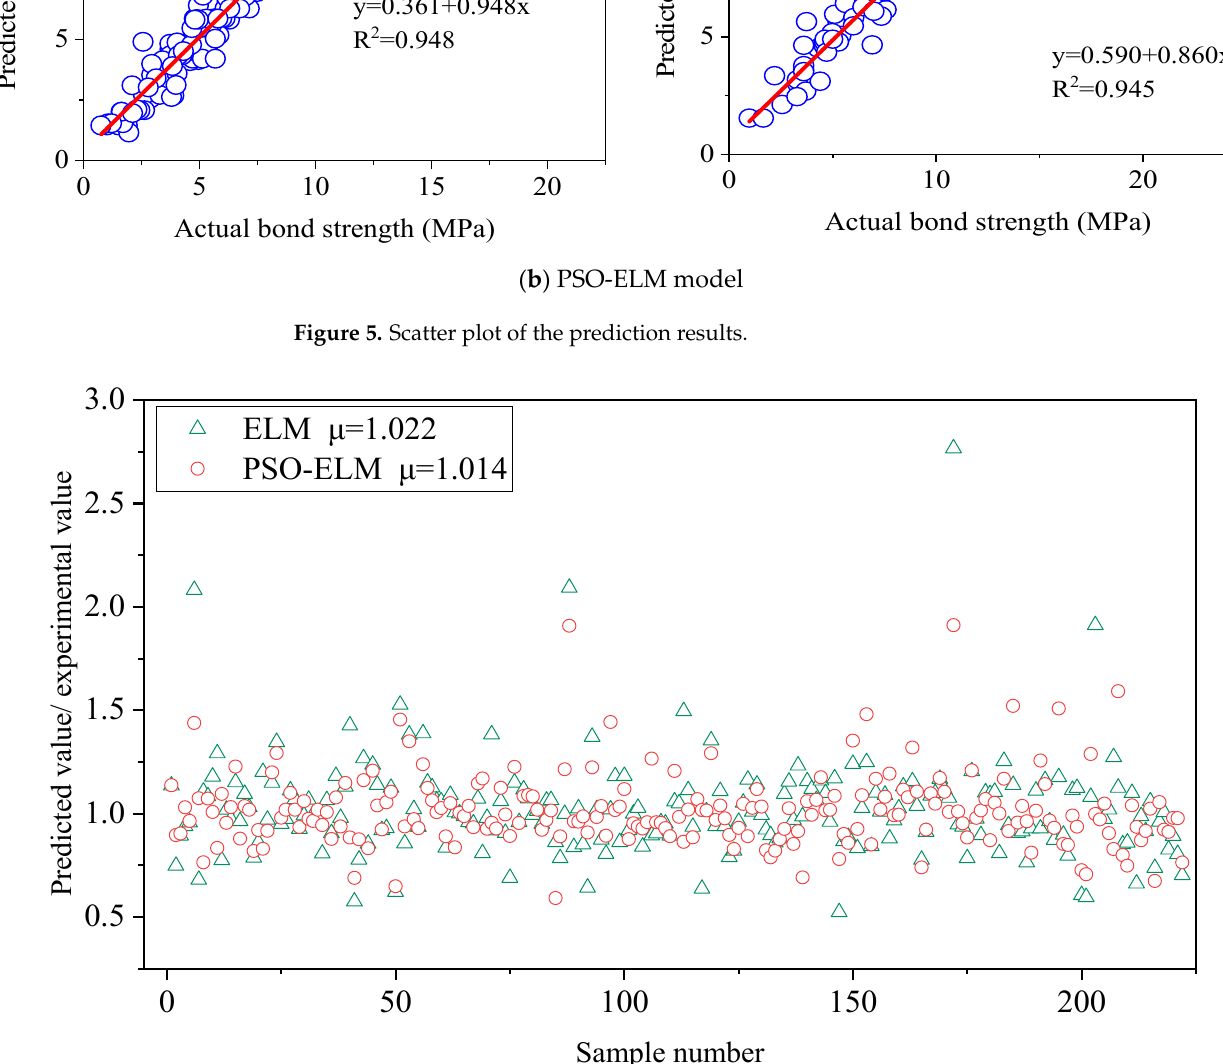
Figure 6. The proportion between the predicted and actual bonding strength. Table 2. Model prediction results and relative errors of the test set.